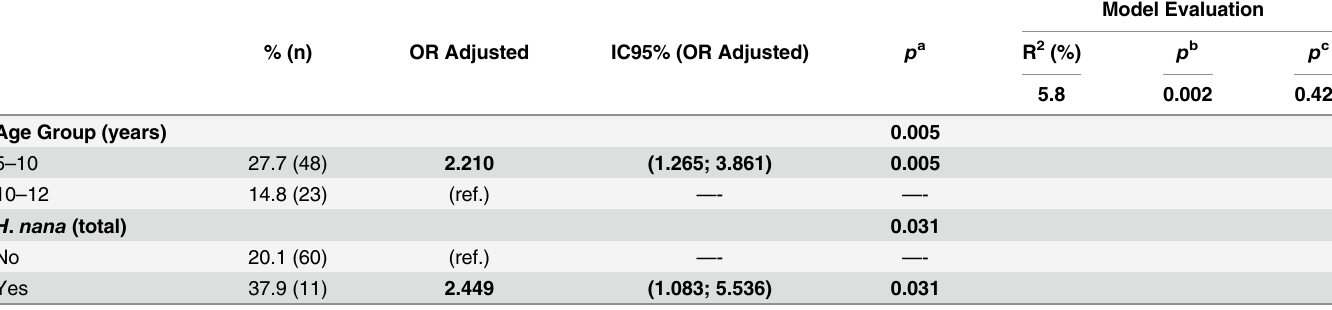
Table 7. Multivariate regression model for anemia